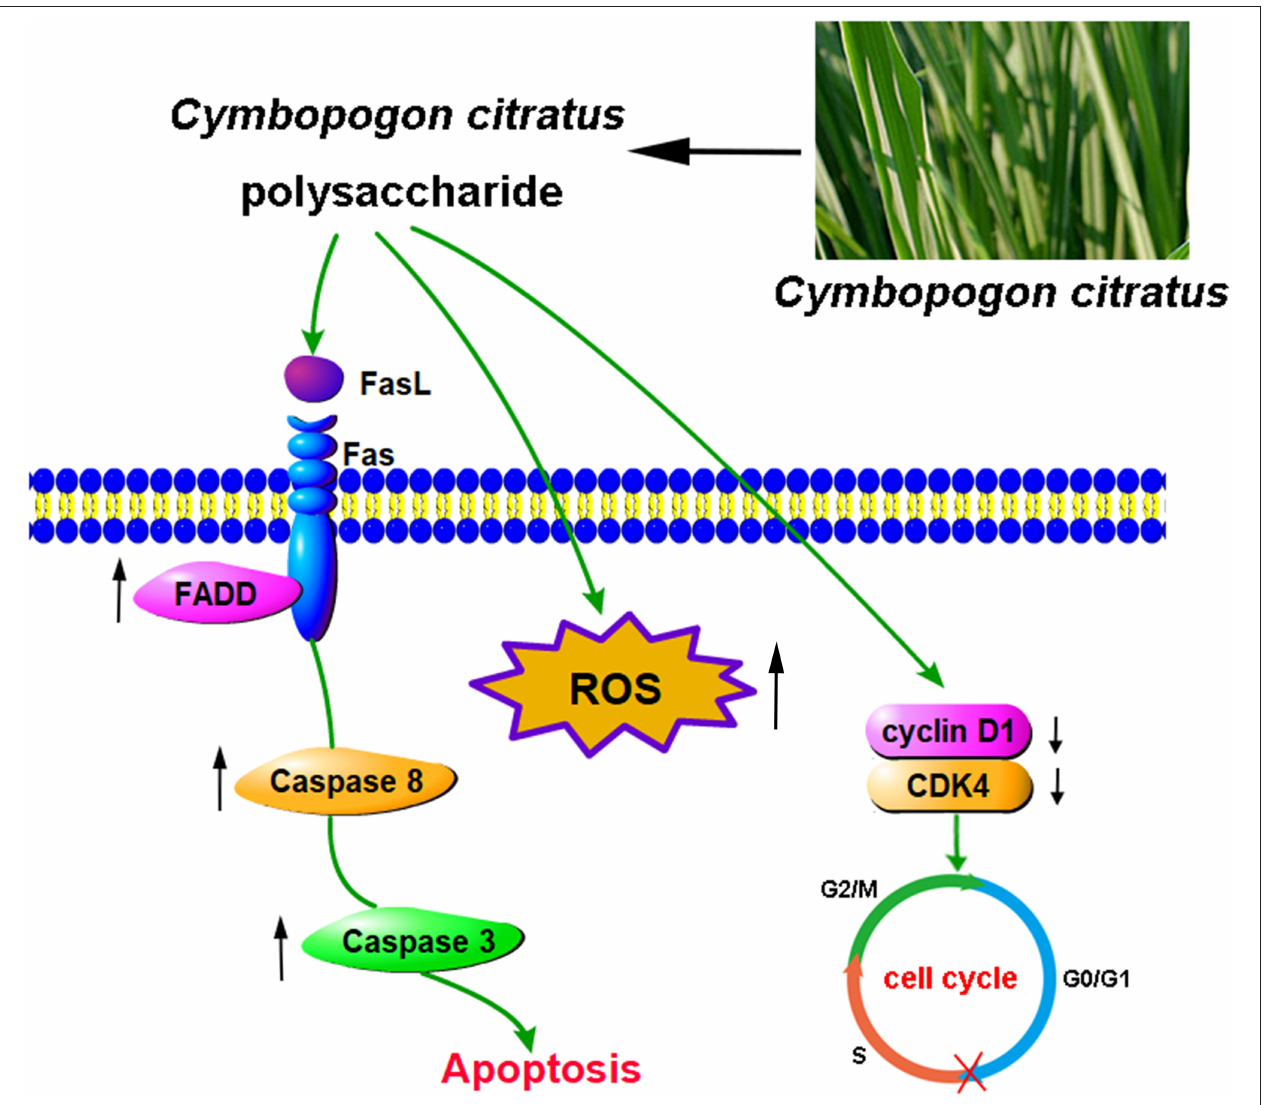
FIGURE 8 | The proposed molecular mechanisms of cell cycle arresting and apoptosis induced by CCP in MDA-MB-231